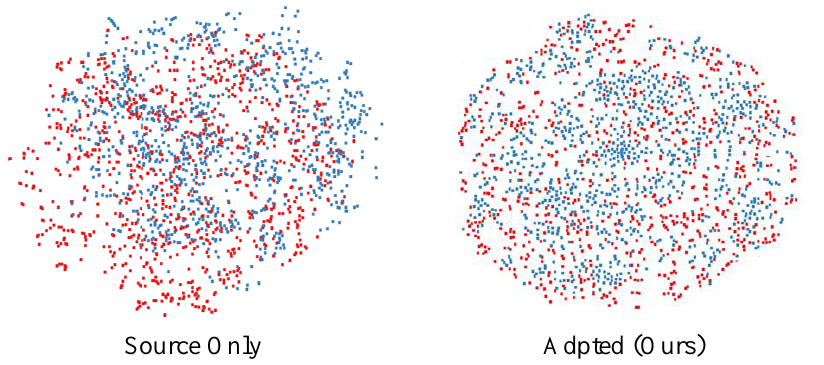
Figure 7. We randomly selected 1920 samples of synthetic and real-world images and used t-SNE [50] to visualize the features learned by the source-only model and our MarsDA model, respectively. The red points are samples in the source domain while the blue points are samples in the target